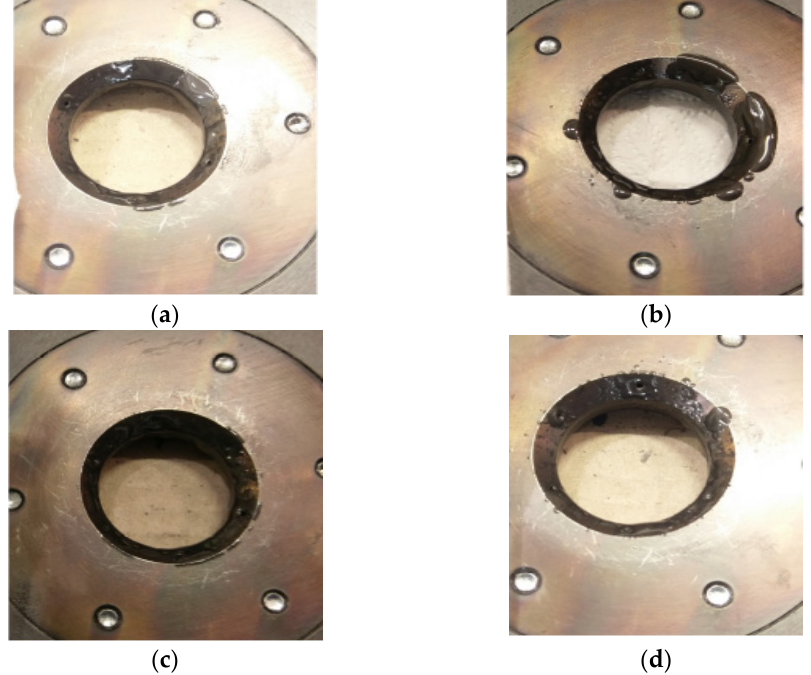
Figure 7. Lubricant remaining on the die for particular test parameters: ( a ) variant 1; ( b ) variant 3; ( c ) variant 2; ( d ) variant 4.